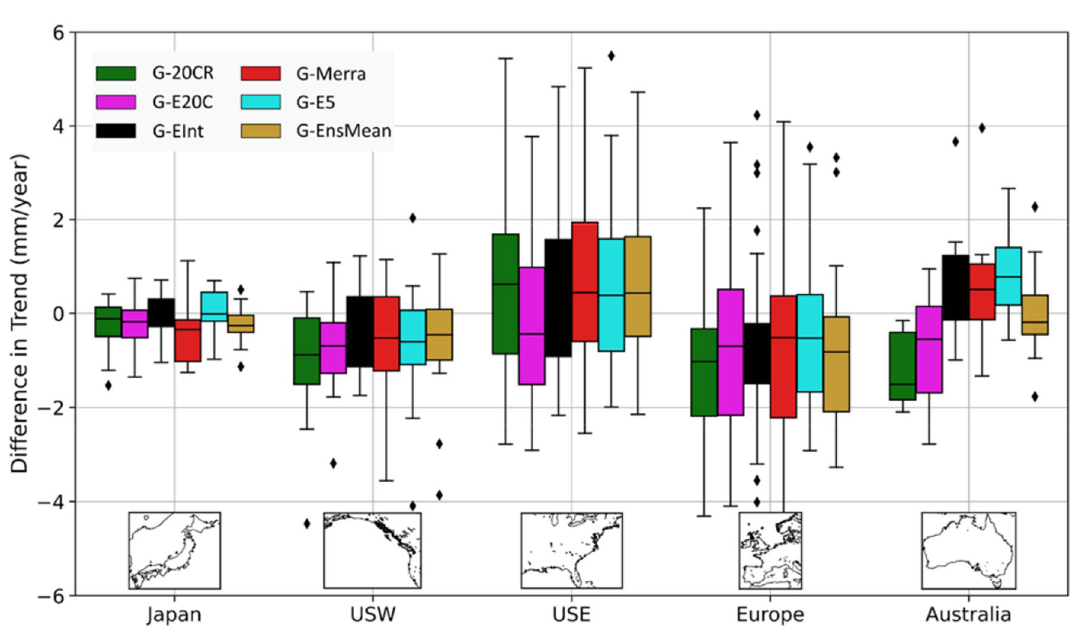
Figure 10. Comprison of GSSR trends with observed trends for six reconstructions (including ensemble mean) and five regions. GSSR trends are subtracted from observed trends, including their signs. Boxes indicate the interquartile range (IQR) (difference between 75 and 25th percentiles), upper and lower marks represent 75th percentile + 1.5 * IQR and 25th percentile – 1.5 * IQR respectively, and diamonds are considered